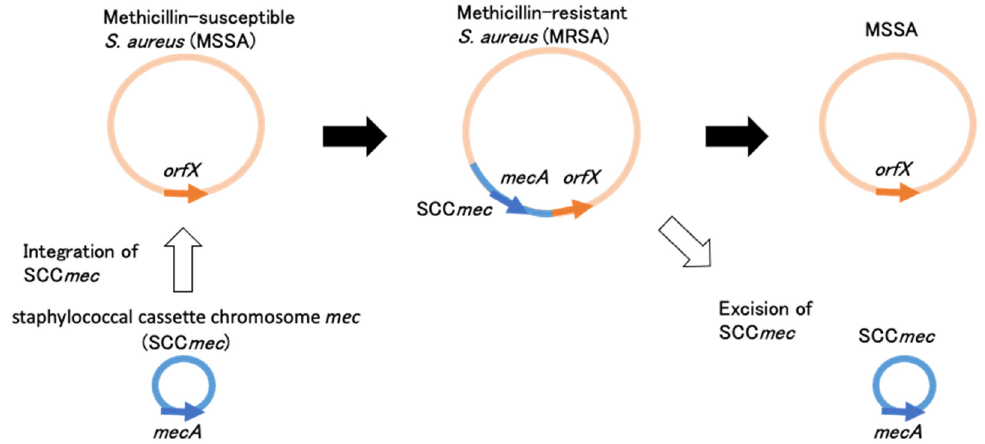
Figure 1. Schematic representation of SCC mec excision and integration in S. aureus . Mobile genetic elements containing mecA and their regulatory genes were designated as staphylococcal cassette chromosome mec (SCC mec ) and were first reported in strain N315 (Sequence type 5, NY/JAPAN clone), of which the whole-genome sequence was subsequently revealed, followed by other strains, NCTC10442 and 85/2082 [12–14]. The SCC mec in NCTC10442, N315, and 85/2082 were designated as SCC mec I, SCC mec II, and SCC mec III, respectively [13].